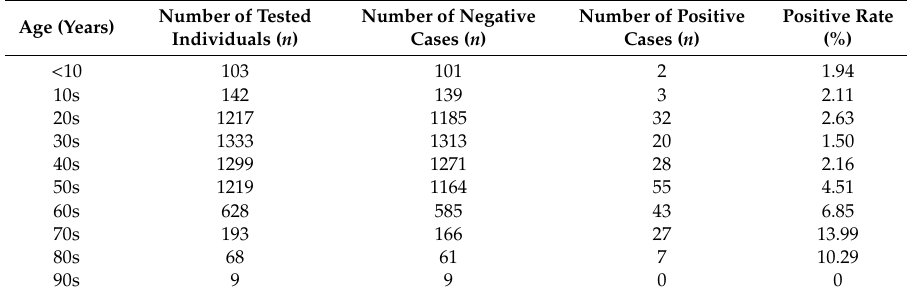
Table 3. The number of tested individuals, number of SARS-CoV-2-negative and -positive cases, and positive rates according to age ranges.